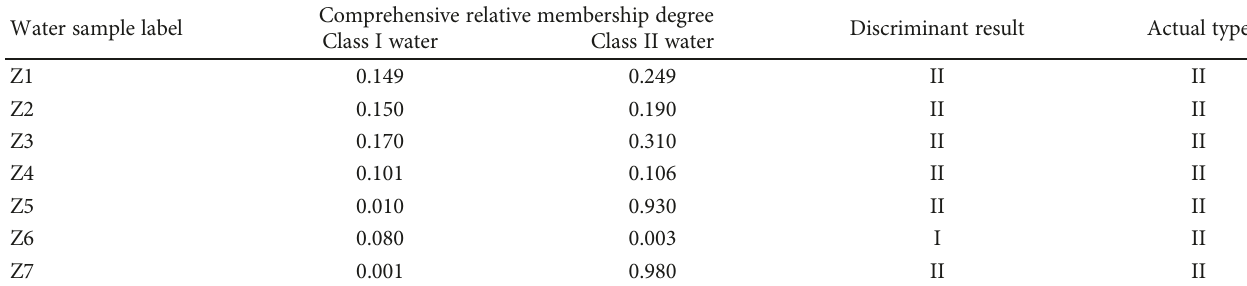
Table 5: Identi fi cation results of water inrush.